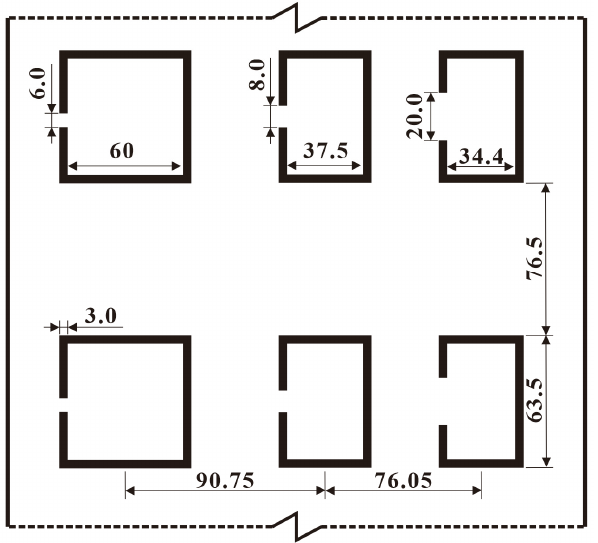
Figure 9. Schematic of the final optimized configuration of LRSCs (units: mm).